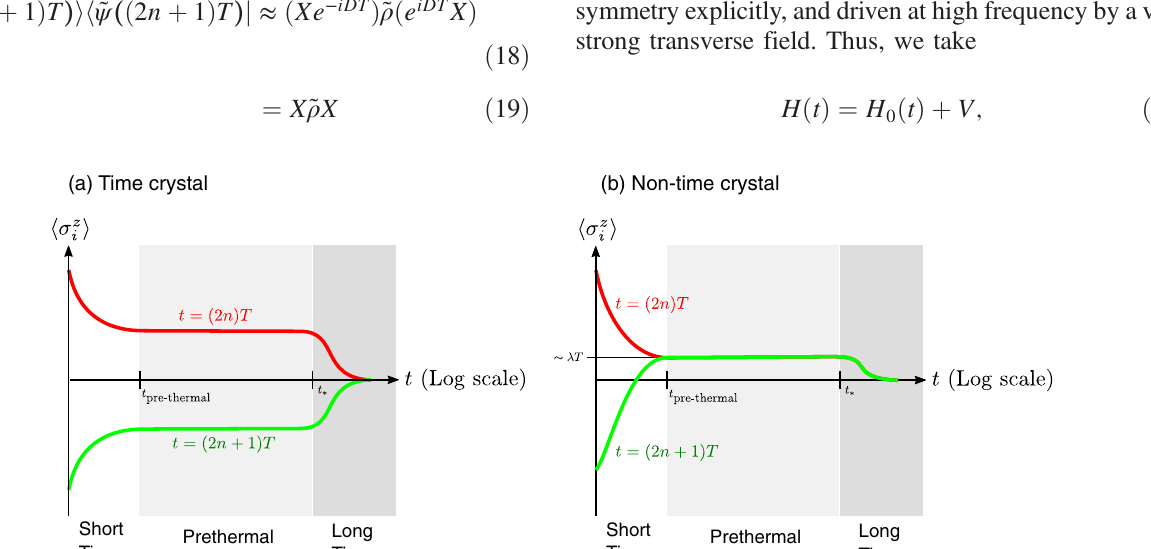
FIG. 1. The expected time dependence of h σ z i at stroboscopic times, starting from a low-temperature state with respect to U D U † (for i example, for a state with all spins polarized in the z direction.). Panel (a) shows the prethermal time-crystal phase, and panel (b) shows the non-time-crystal prethermal